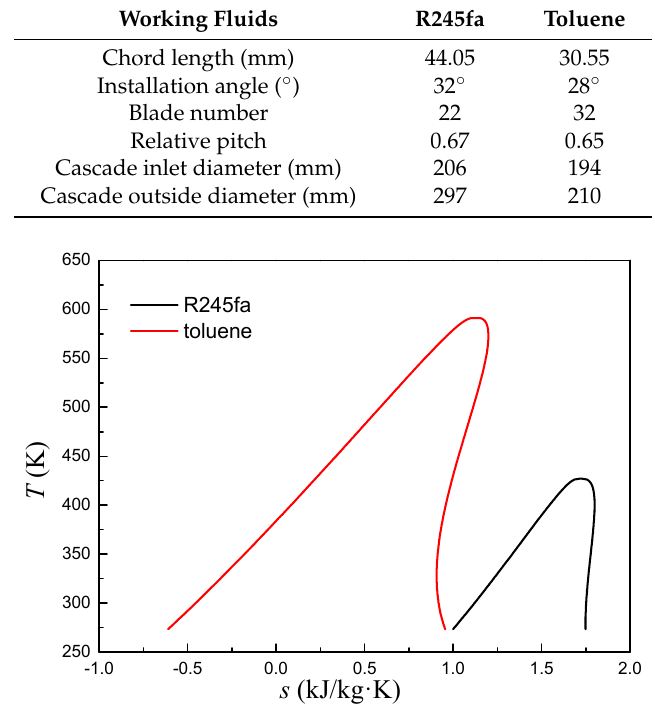
Figure 13. The T ‐ s plots for working fluids. Figure 13. The T-s plots for working